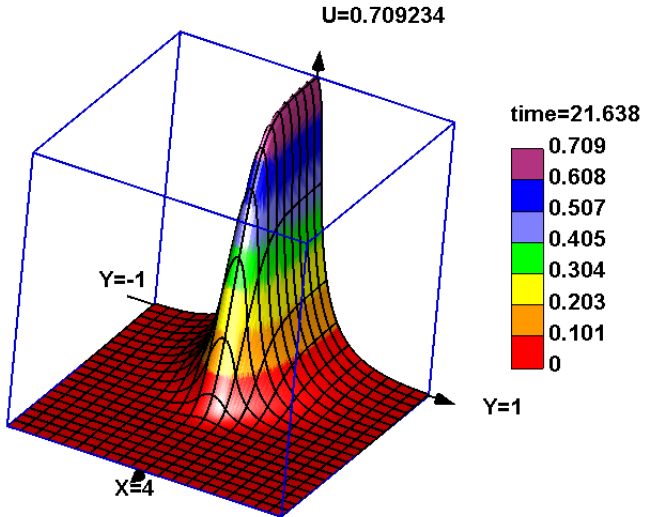
Figure 1. A snapshot of solution u ( x , y , t ) of Equation (1) without immune response ( f ( u ) = 0) and with a piece-wise constant genotype-dependent mortality σ ( y ) . The cross section in the y -direction Figure 1: A snapshot of solution u ( x, y, t ) of equation (1.1) without immune response ( f ( u ) = (genetic variable) shows a stationary distribution describing virus quasi-species. It has a maximum 0) and with a piece-wise constant genotype-dependent mortality σ ( y ). The cross section in for some most frequent genotype, and it rapidly decays as the genotype moves away. This virus quasi-species progresses in the tissue (variable x